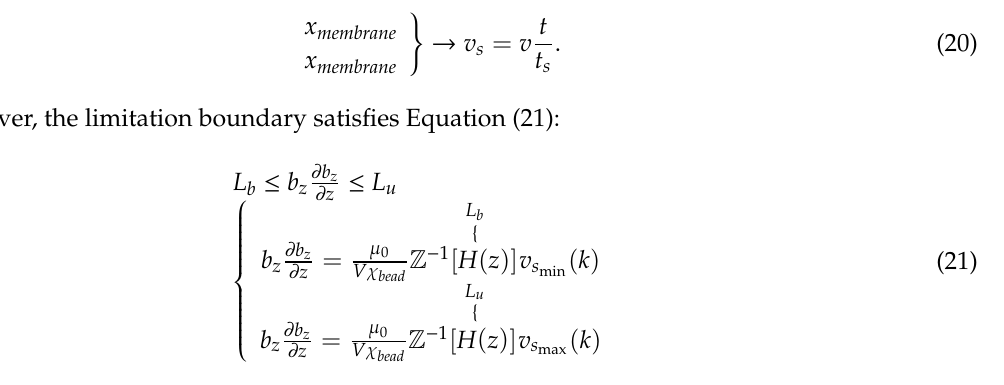
Figure 9. Force needed for crossing through the membrane. This shows the interaction of the force created to cross functionalized carbon nanotubes through the membrane at various velocities between 1 and 2 angstroms per second. This diagram shows an increase in the rate of passage while the crossing velocity is increased. It clearly shows that by increasing the rate of crossing, the interaction forces are increased. The X-axis is the steps, and Y-axis is the force [N]. In this research study, the input system is the impulses that indicate the velocity amplitudes. The system output is the interaction forces derived from the crossing of functionalized CNT through the cell membrane. The order of system is acquired by trial and error with the data and reaching the best fit for the recorded data. In this model, a best fit of 80% with an MSE of around 3 × 10 − 8 was achieved. Equation (2) expresses the transfer function of the system, which is a mathematical relation between the input (velocity) and output (interaction force). The parameters and the values needed for Equation (23) are collected in Tables 1 and 2.